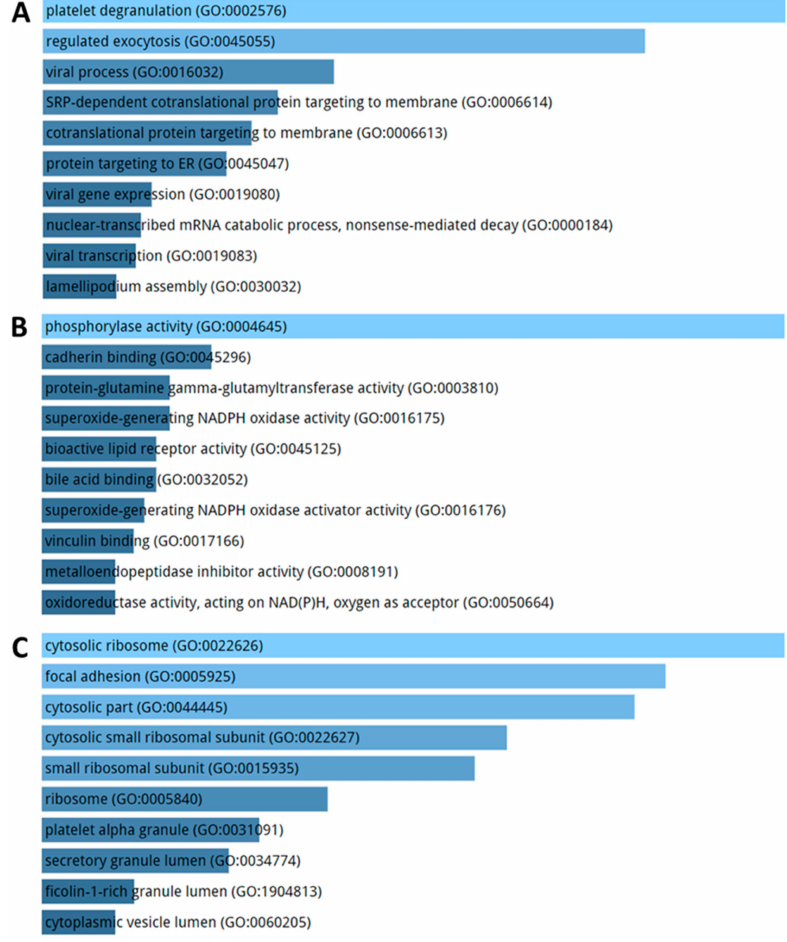
Figure 8. Biological process ( A ), molecular function ( B ) and cellular component ( C ) enrichment analysis performed on DE genes in AD patients compared to healthy controls. The significance of the specific gene-set term is represented by the length of the bar. The significance of the term is indicated by the brightness of the bar’s color (the brighter, the more significant).